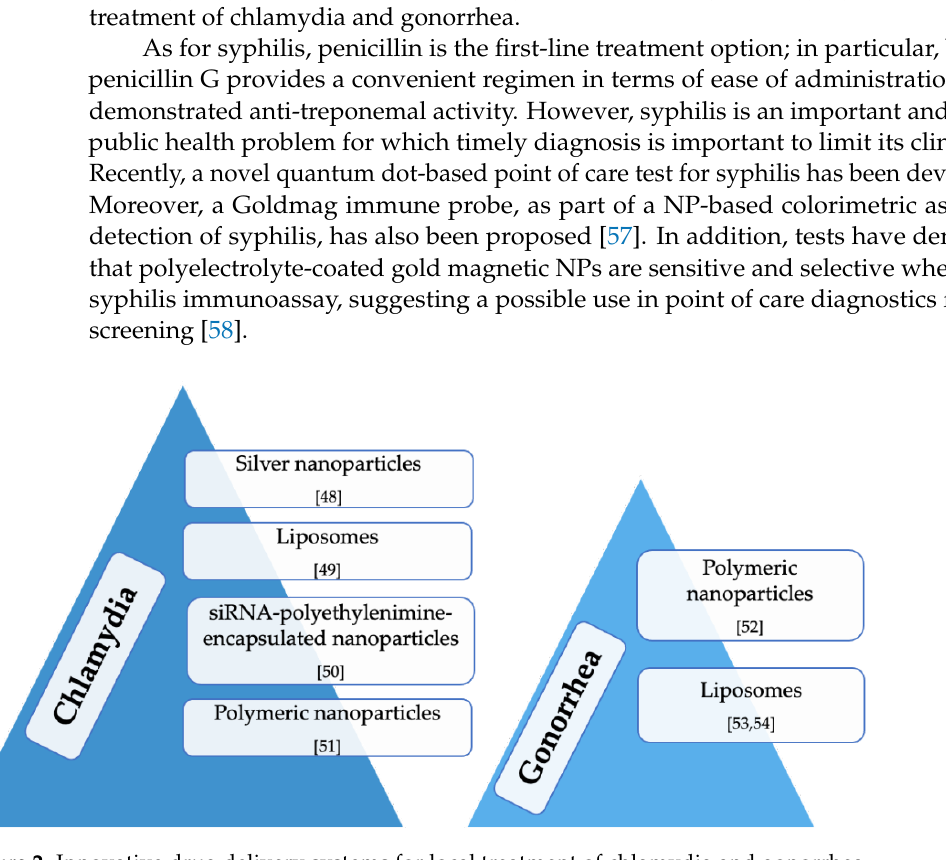
Figure 2. Innovative drug delivery systems for local treatment of chlamydia and gonorrhea.